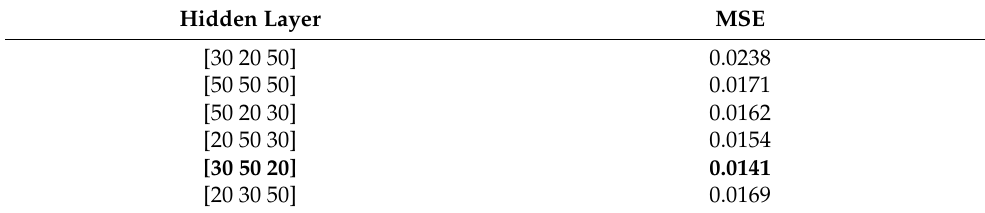
Table 4. MSE of the neural network with three hidden